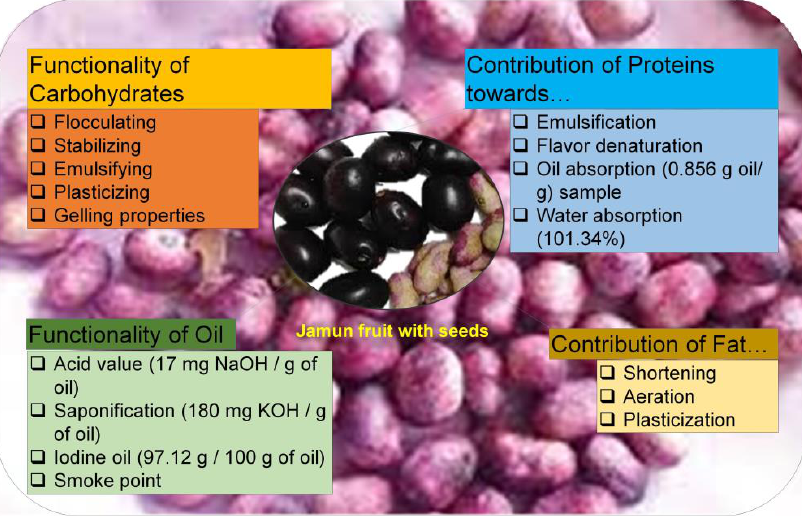
Figure 1. Functional properties of Jamun seeds. Adopted and reproduced from Kumar et al. [10],